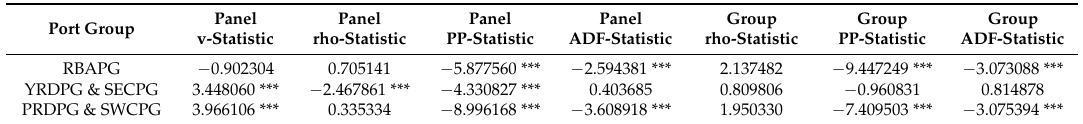
Table 2. Results of panel co-integration